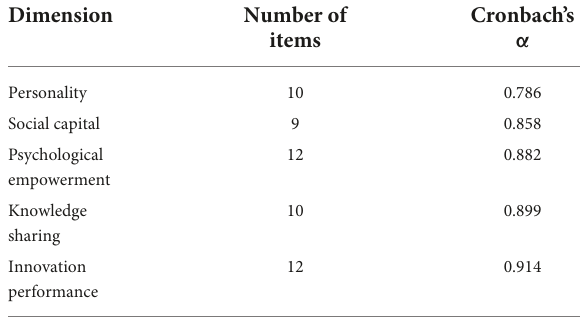
TABLE 2 Reliability analysis of each